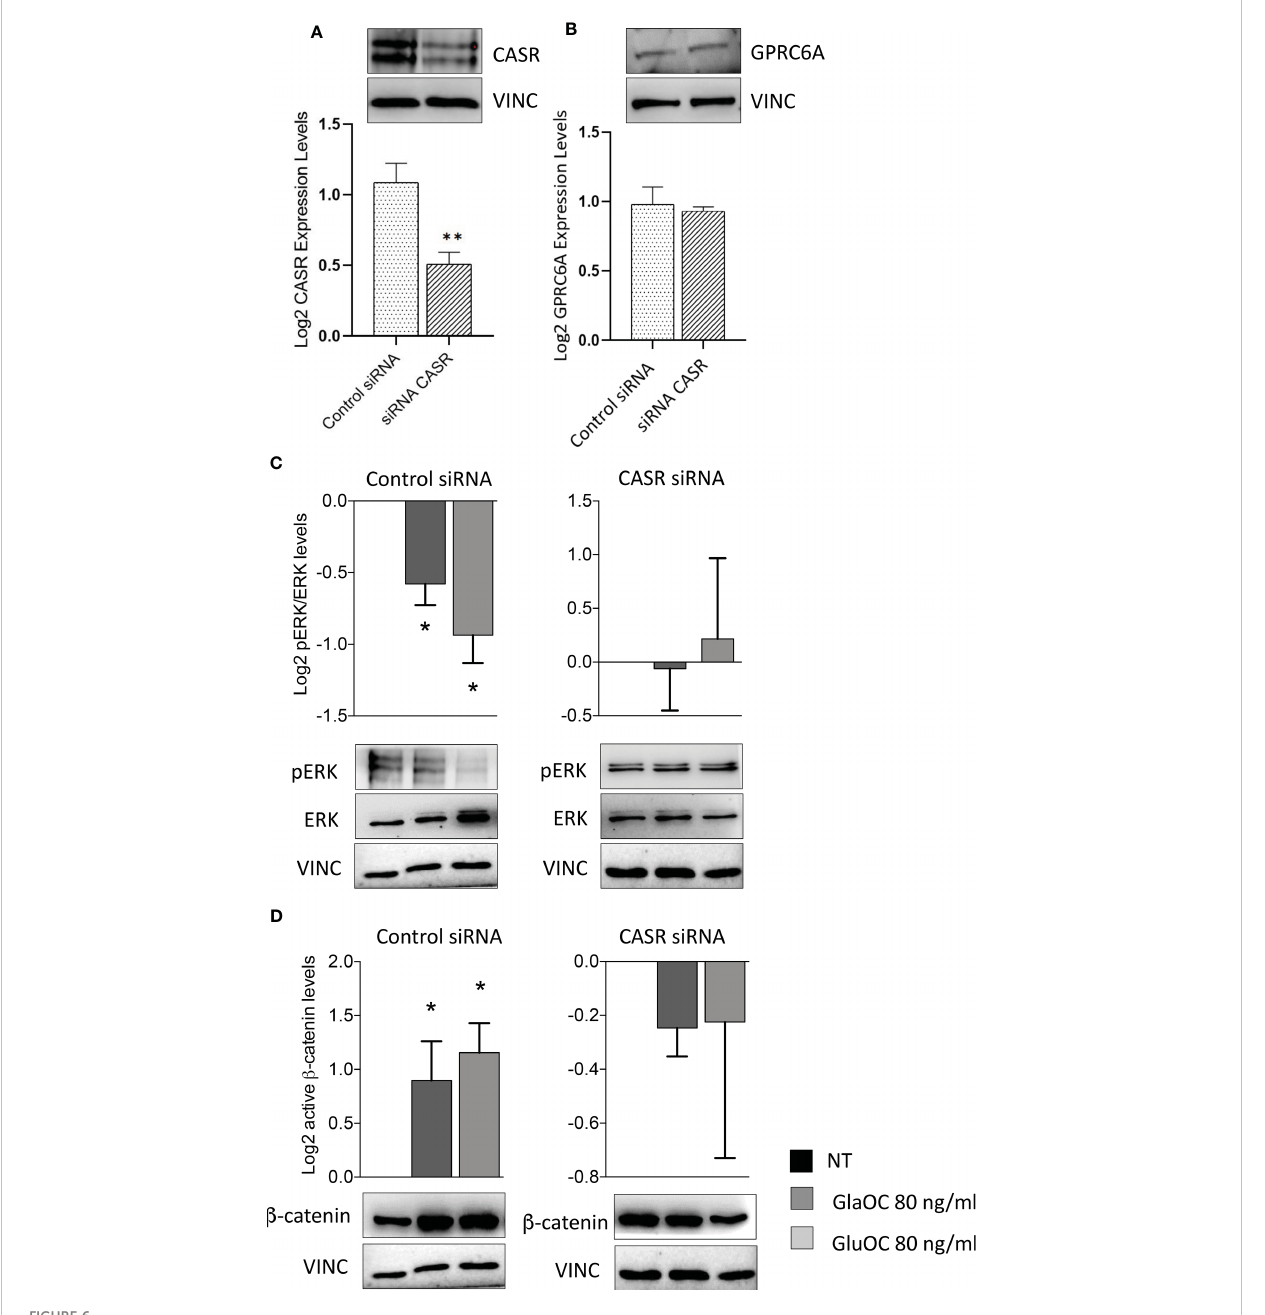
FIGURE 6 Effect of CASR silencing on the GlaOC/GluOC-activated signaling in PAds-derived cells. (A) Effect of the CASR silencing on CASR protein expression (**, P=0.0043). (B) Effect of the CASR silencing on GPRC6A protein levels; expression levels are presented as fold changes versus untreated conditions incubated with control siRNA, and log2 transformed. (C) Effects of GlaOC (dark grey columns) and GluOC (light grey columns) stimulation in PAds-derived cell preparations treated with control siRNA and with CASR siRNA on pERK/ERK levels (*, P<0.05). (D) Effects of GlaOC (dark grey columns) and GluOC (light grey columns) stimulation in PAds-derived cell preparations treated with control siRNA and with CASR siRNA on active b - catenin levels (*, P<0.05). Densitometric data were log2 transformed and presented as mean±SEM. A representative western blot is shown for each experimental